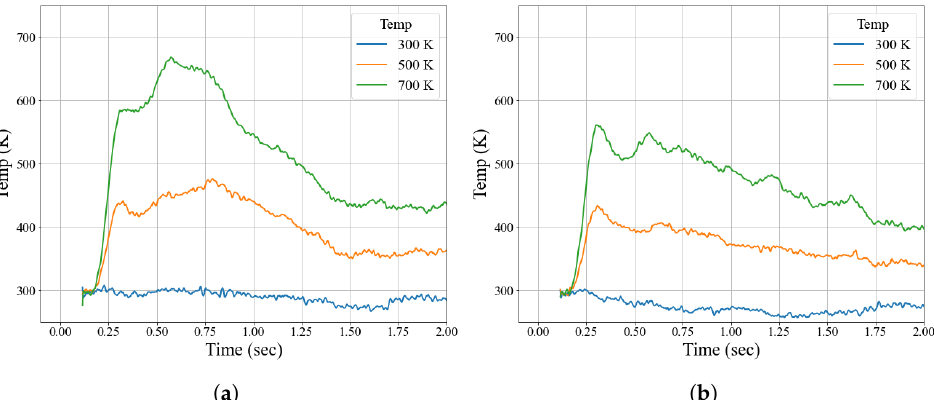
Figure 8. Calculated total temperature using T env = T ( t ) + ˙ T ( b ) Valves